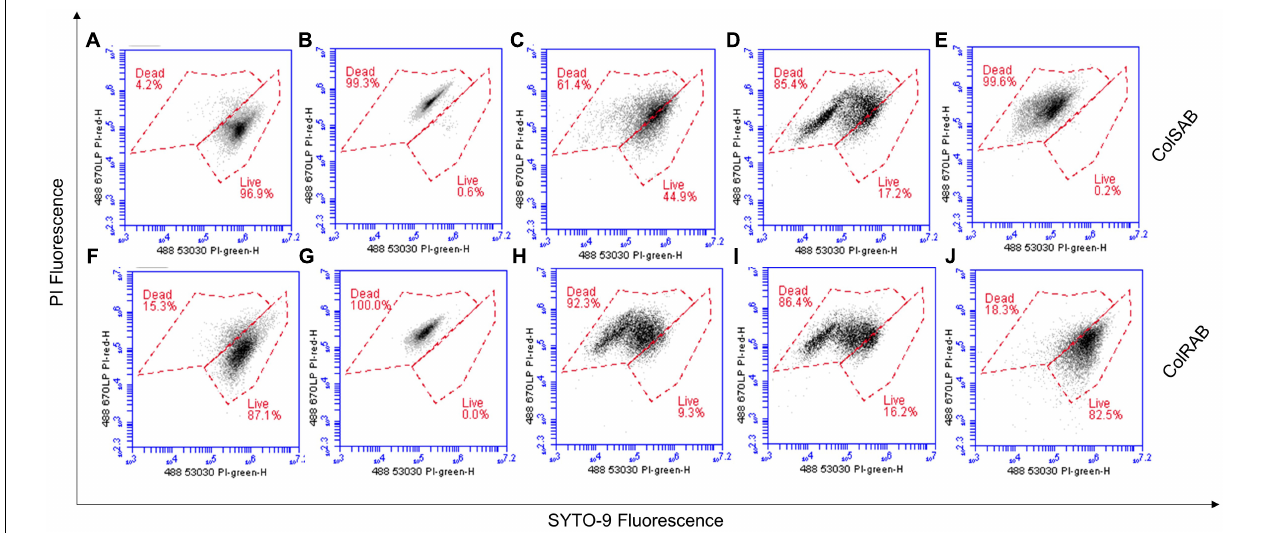
FIGURE 7 | Analysis of the effects of NuriPep 1653 on the membrane integrity and viability of colRAB and colSAB. Quantification of viable versus non-viable cells represented by the uptake of fluorescent PI in (A) untreated colSAB; (B) heat inactivated colSAB at 95 ◦ C for 60 min; (C) colSAB treated with NuriPep 1653 at 12 µ g/mL; (D) colSAB treated with magainin 2 at 12 µ g/mL; (E) colSAB treated with colistin at 4 µ g/mL; (F) untreated colRAB; (G) heat inactivated colRAB at 95 ◦ C for 60 min; (H) colRAB treated with NuriPep 1653 at 12 µ g/mL; (I) colRAB treated with magainin 2 at 12 µ g/mL; (J) colSAB treated with colistin at 4 µ g/mL. A minimum of 50,000 single events were collected per sample. Data is displayed as scatter plots of PI fluorescence ( y -axis) and SYTO-9 fluorescence ( x -axis). When used alone, the SYTO9 stain generally labels all bacteria in a population. In contrast, PI penetrates only bacteria with damaged membranes, causing a reduction in the SYTO9 stain fluorescence when both dyes are present. Therefore, bacteria with intact cell membranes stain fluorescent green, whereas bacteria with damaged membranes stain fluorescent red. Optical densities of bacteria were optimized for cell